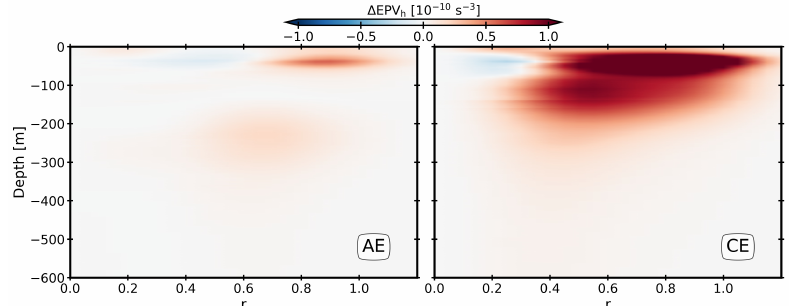
Figure 20. The horizontal component of the EPV anomaly for the CE and